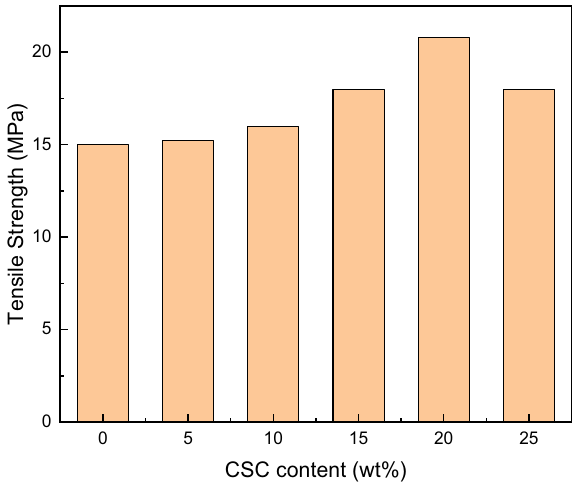
Figure 8. Tensile strength drawing of the composites.